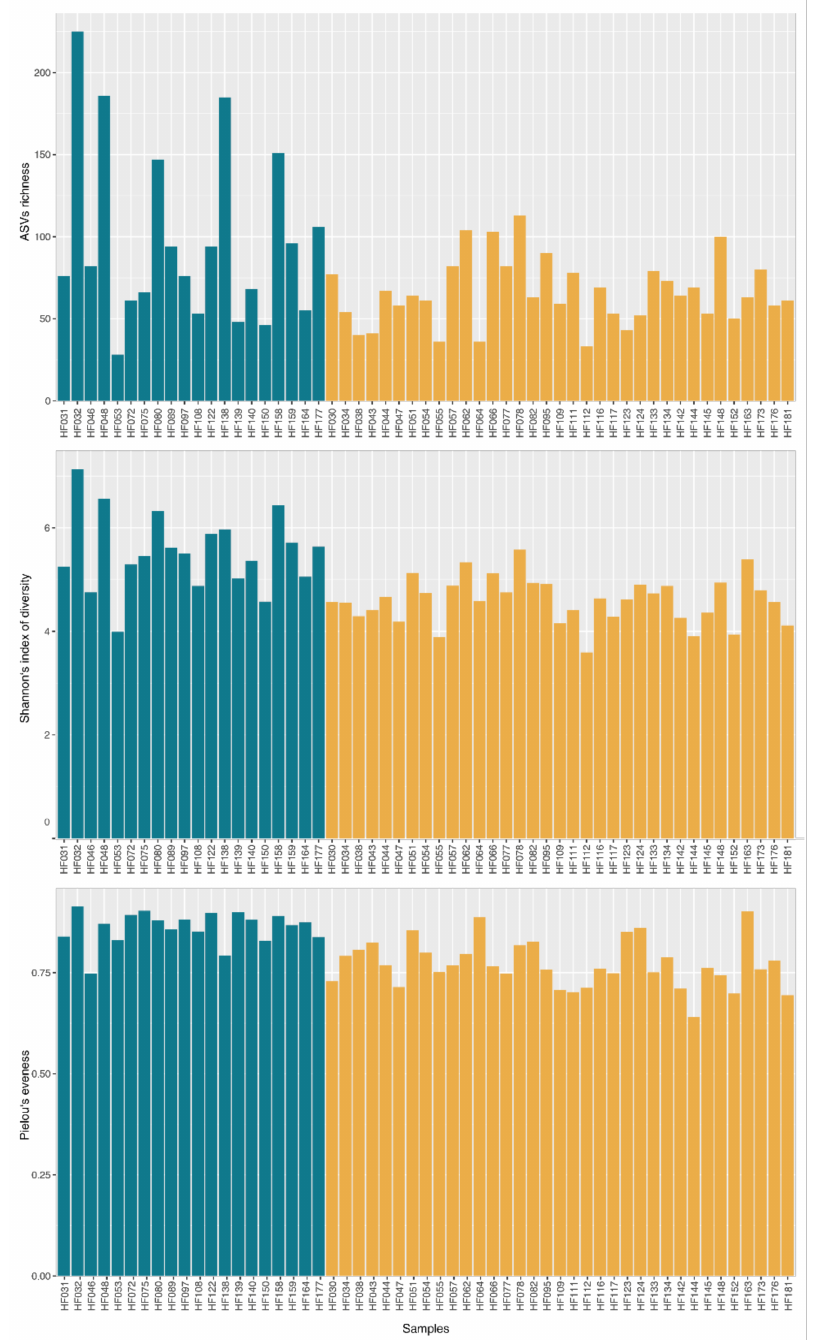
Figure 2. Diversity indices of microbial communities in the ejaculates of clinically healthy breed- ing